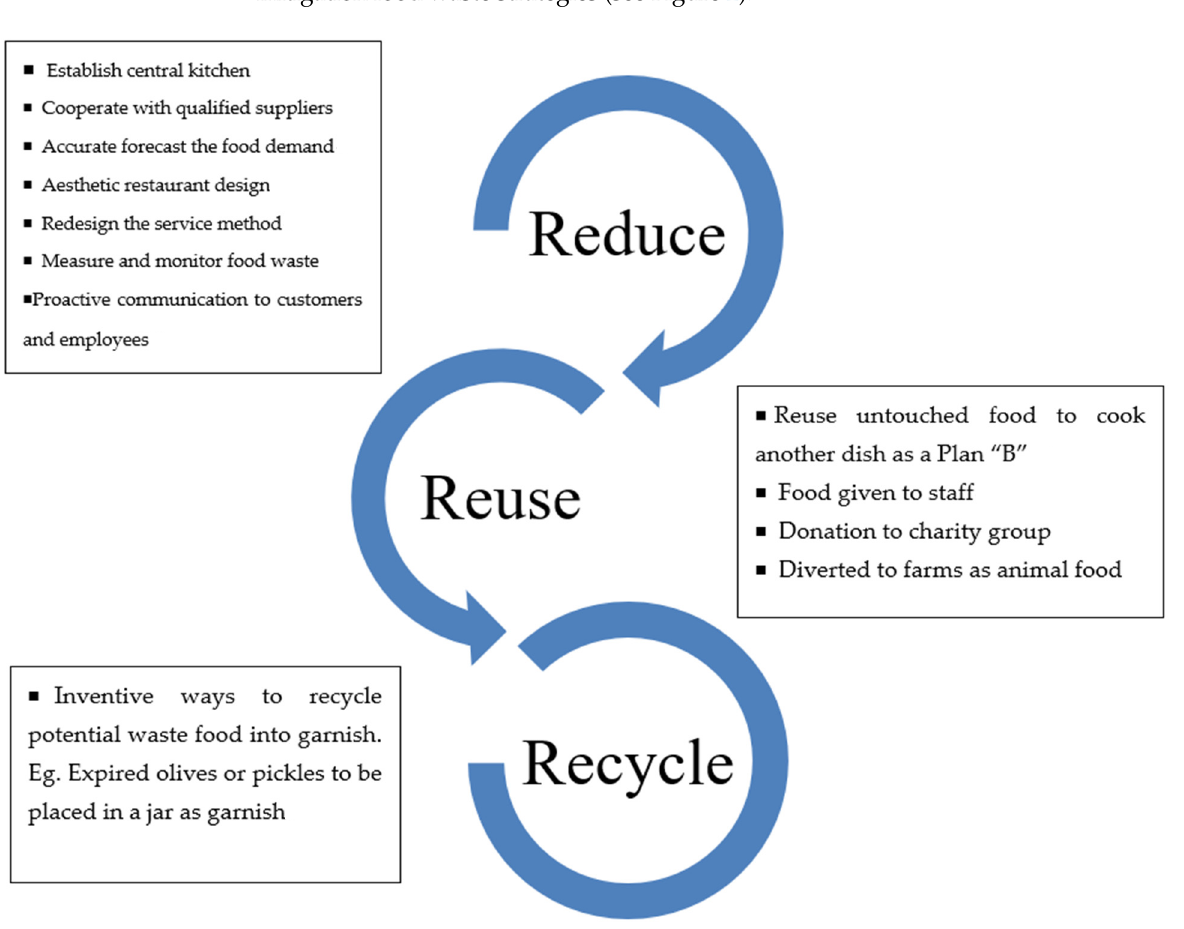
Figure 2. Strategies of hierarchy mitigation food waste in buffet restaurants.